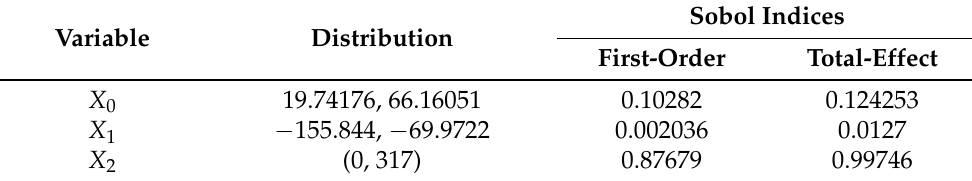
Table 5. First-order and total-effect Sobol indices measuring model sensitivity to parameters in symbolic expression for the estimation of the number of deceased cases for the entire U.S. ( X 0 latitude, X 1 longitude and X 2 day).